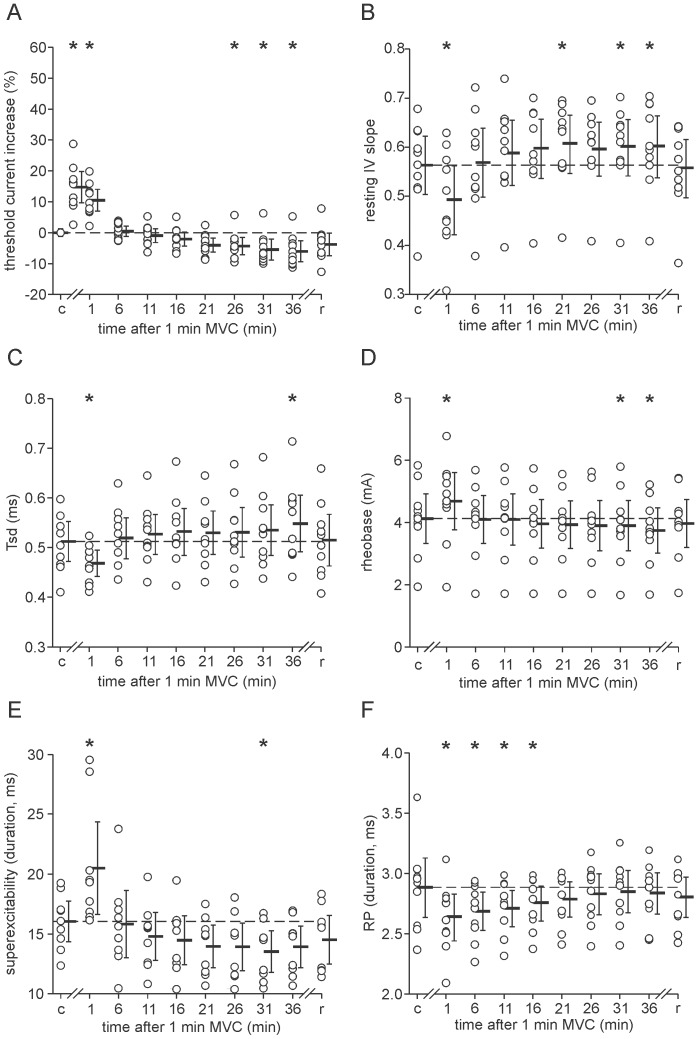
Recovery of axonal excitability after sustained activity.Open symbols represent the data for each subject; pooled data are presented as mean (solid bars) and 95% confidence intervals. A: threshold current. B: resting IV slope. C: τ
SD. D: rheobase. D: the duration of the superexcitable period. F: the duration of the refractory period (RP). *: p<0.05.